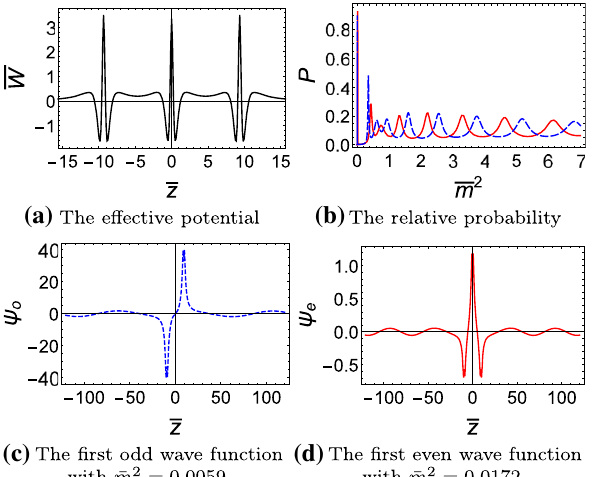
Fig. 16 The effective potential, the relative probability, and wave functions of the first odd and even KK resonance with ¯ b = 5 and ¯ α = − 0 . 0373 for case 2